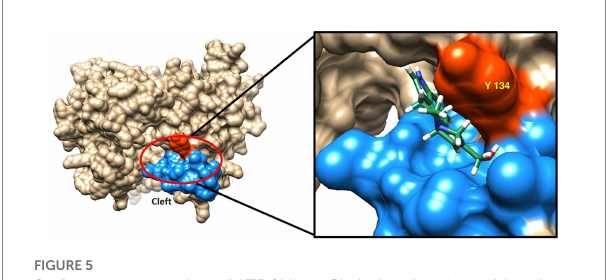
FIGURE 5 Surface representation of AT5 9Hypo CloA showing the residues in the F-G loop together with a protruding tyrosine residue potentially forming an elymoclavine binding site. The inserted residues are colored blue while the protruding tyrosine residue Y134 is highlighted in red (Left). Elymoclavine shown in ball and stick representation can be docked into this cleft